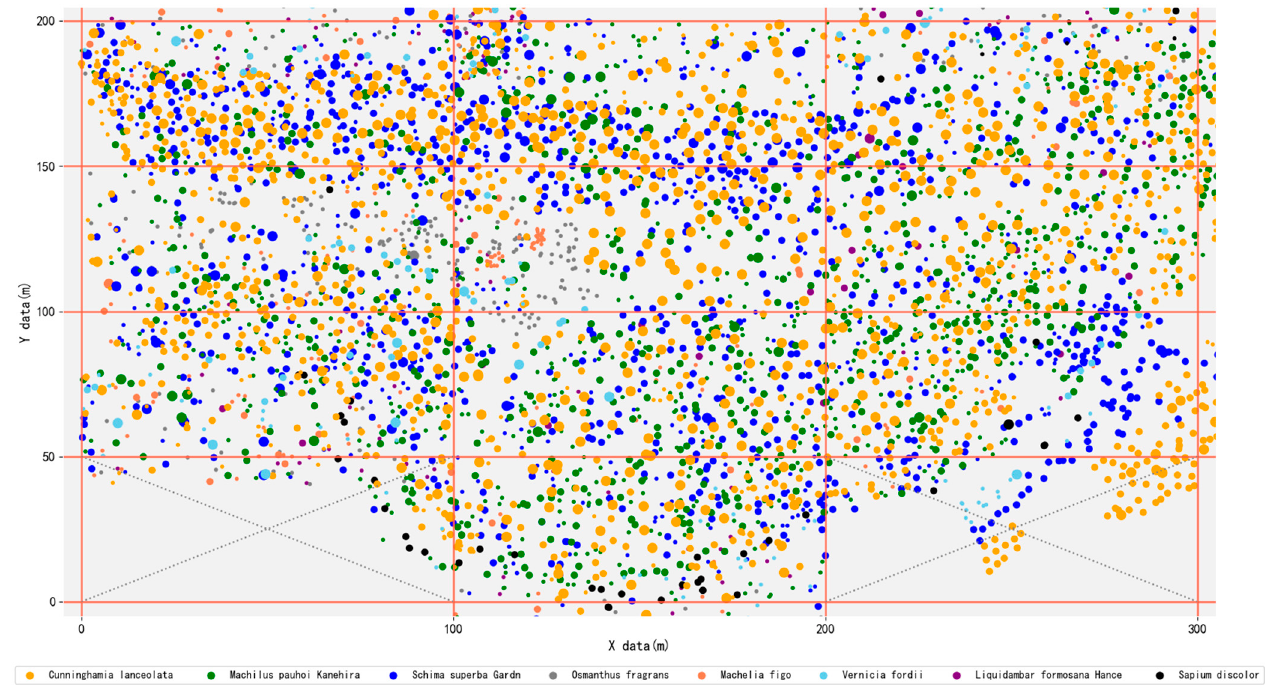
Figure 2. Spatial distribution of eight dominant tree populations at different layers in 5 ha (50 m × 100 m) planted mixed forest in Shanxia Forest Farm. The upper layer tree was tree height (H) > 20 m; the middle layer tree was 10 m ≤ H <20 m; and the lower layer tree was 1.3 m ≤ H < 10 m.